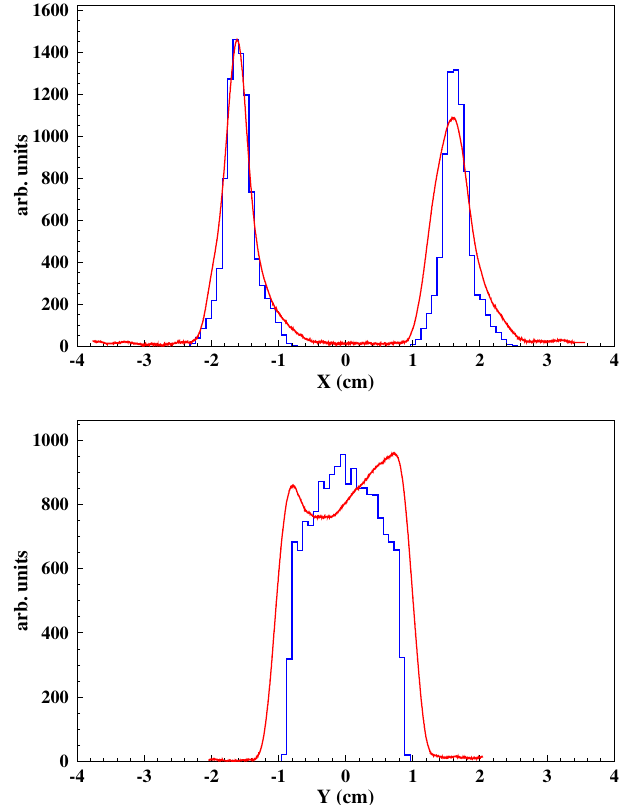
FIG. 4. (Color) The curves are the horizontal (top) and vertical (bottom) beam profiles for a two charge state bismuth beam ð 20 þ ; 21 þÞ measured at the wire scanner behind the first mag- net. The histograms are the results of a TRACK fit to extract the initial beam conditions at the